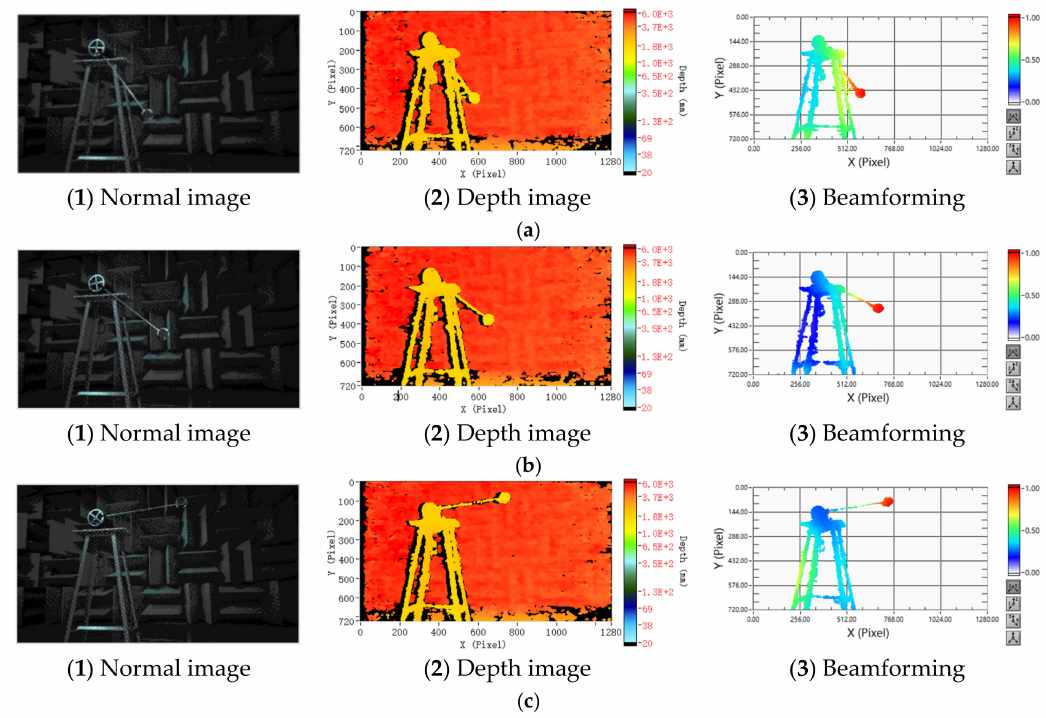
Figure 7. Sound source localization results of layout 1 (1000 Hz) in the experiment. ( a ) Images of the Start position. ( b ) Images of the Middle position. ( c ) Images of the End